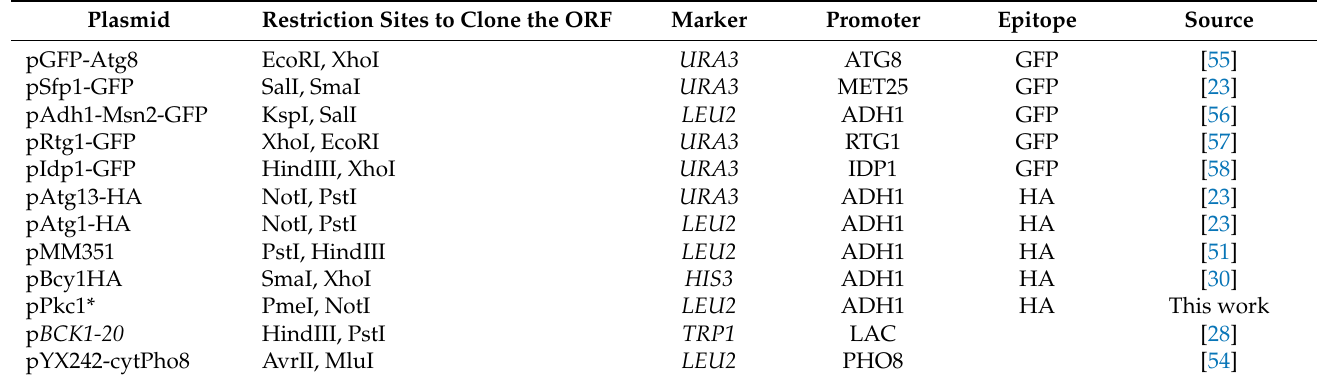
Table 2. Plasmids